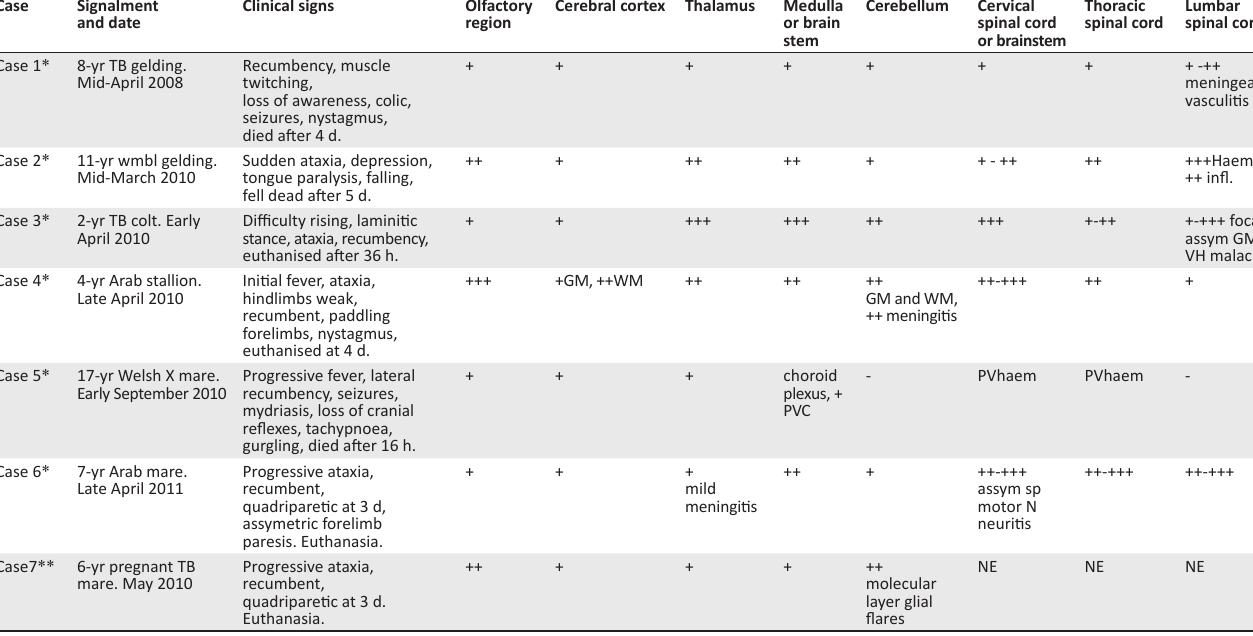
TABLE 1: Signalment, clinical signs, comparative severity and distribution of central nervous system histological lesions of naturally occurring fatal equine West Nile virus positive Cases 1−7.